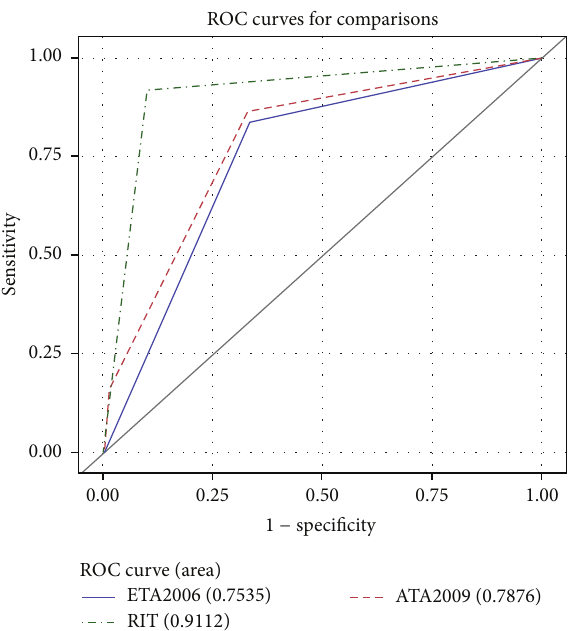
Figure 1: Area under ROC curve to detect recurrence/persistent disease for each risk stratification